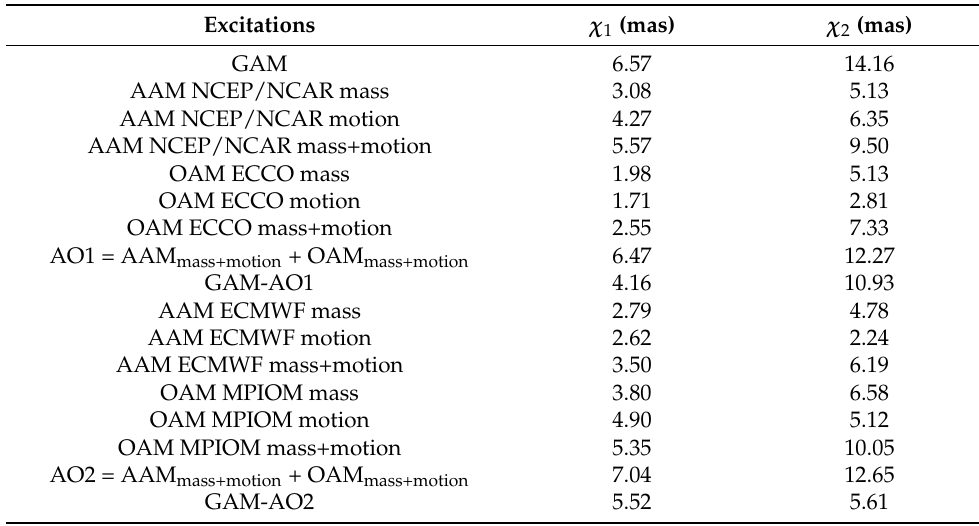
Figure 3. ( a ) Monthly interannual excitations of geodetic GAM excitations and different combinations of geophysical mass and motion terms of χ 1 and χ 2 components (AO1, AO2): ( b ) GAM vs. AAM NCEP/NCAR and AAM ECMWF of their mass components, ( b ) GAM vs AAM NCEP/NCAR and AAM ECMWF of their mass + motion components, ( c ) GAM vs. AAM NCEP/NCAR mass+motion + OAM ECCO 080 mass and AAM ECMWF mass+motion + OAM MPIOM mass components, ( d ) GAM vs. AO1 = NCEP/NCAR mass+motion + OAM ECCO 080 mass+motion , and AO2 = AAM ECMWF mass+motion + OAM MPI- OM mass+motion geophysical excitations. Table 1. RMS of the GAM interannual excitations and of the different interannual mass and motion terms of geophysical excitations from different